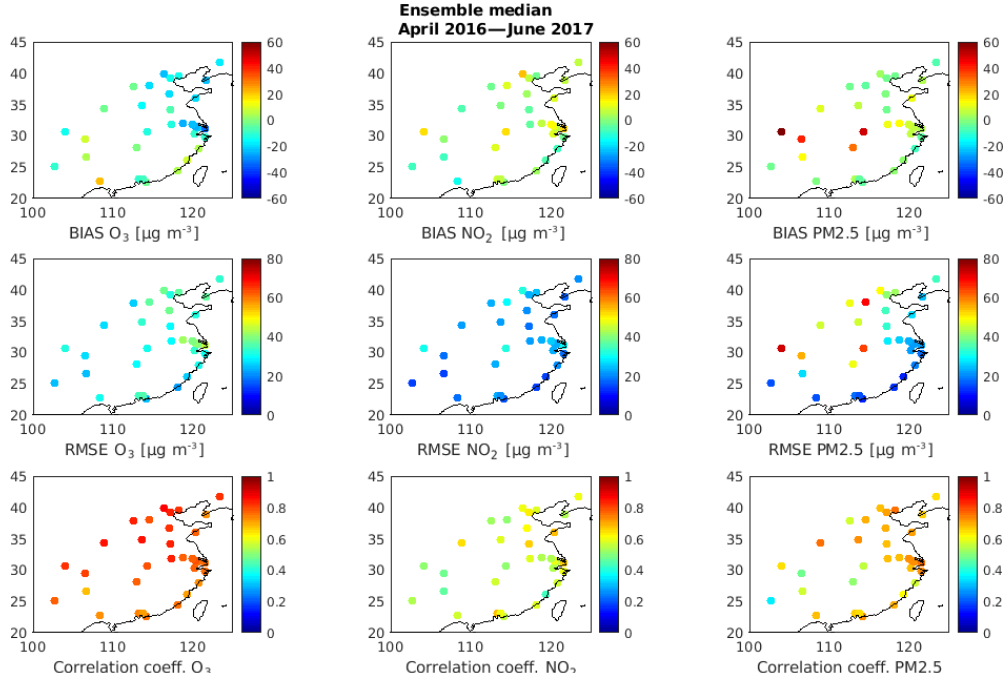
Figure 5. Map of the BIAS, RMSE, and temporal correlation coefficient of O 3 , NO 2 , and PM 2 . 5 for the whole time period (April 2016 until June 2017) for each